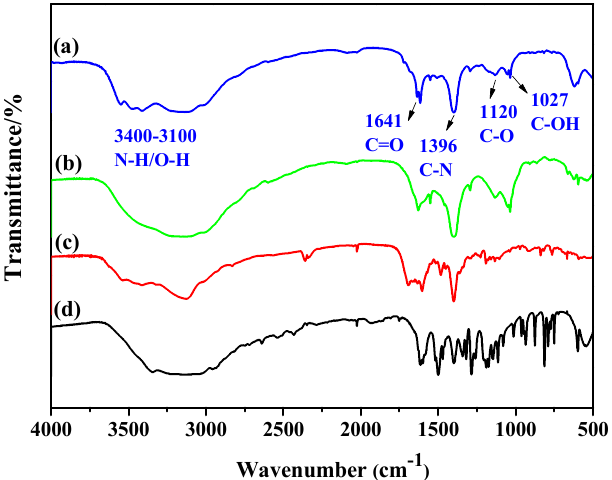
Figure 4. FTIR spectra of ( a ) FA-PDA FONs; ( b ) Polydopamine; ( c ) Folic acid; ( d ) Dopamine.